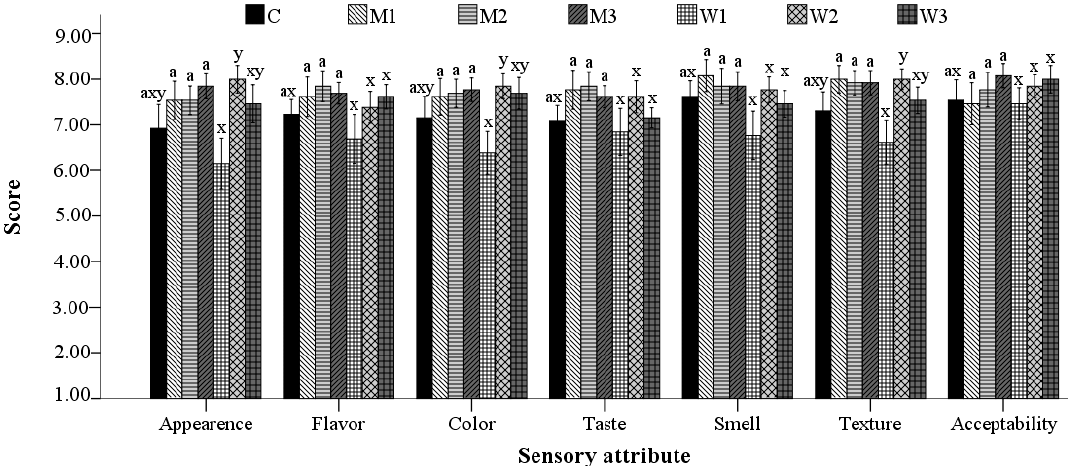
Figure 5. Sensory characteristics of bread samples with different water replacement levels by: milk: M1–12.5%, M2—25%, M3—50% (a, mean values followed by the same letter are not significantly di ff